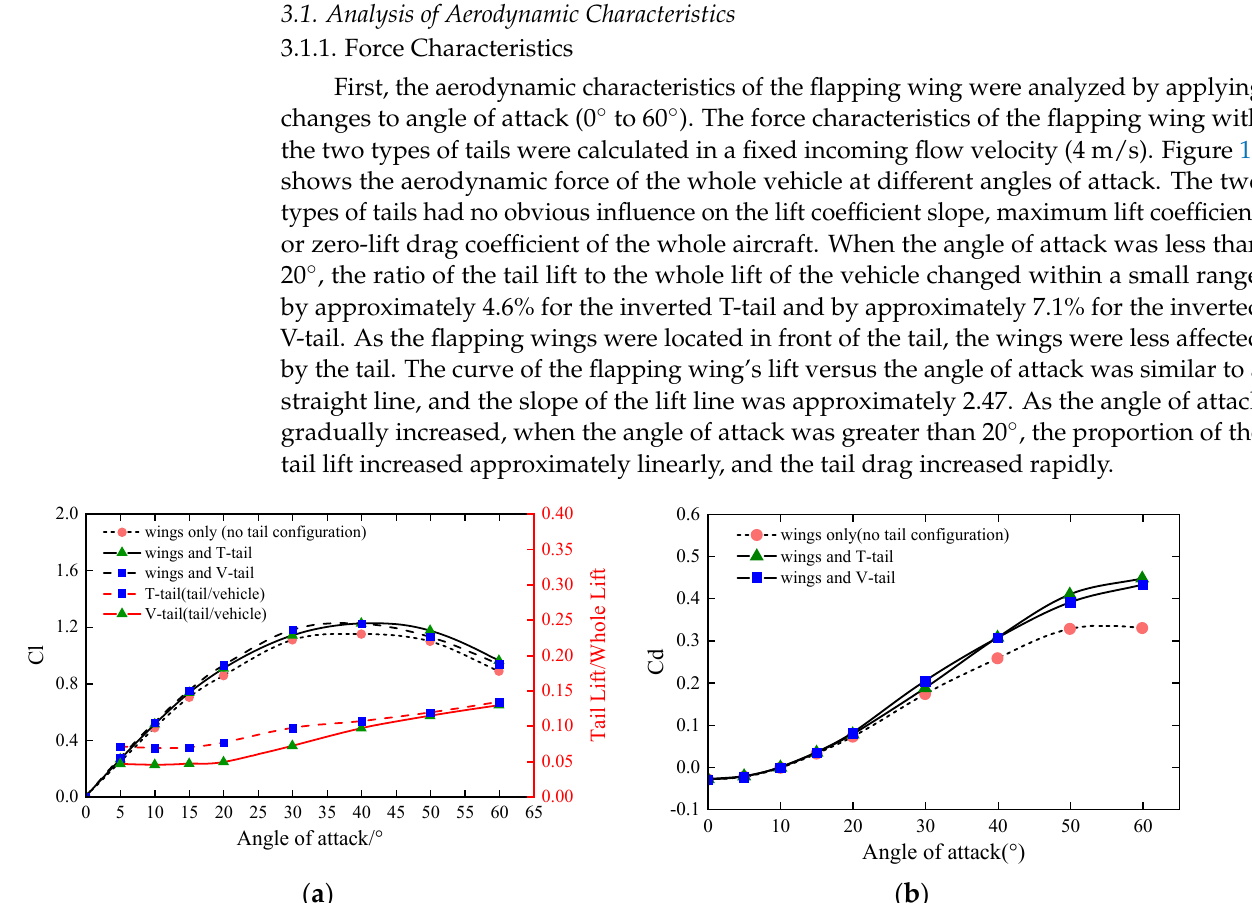
( b ) ( c ) Figure 12. Tails’ force characteristics. ( a ) Lift coefficient curve. ( b ) Drag coefficient curve. ( c ) L/D ratio. 3.1.2. Moment Characteristics In the forward flight state at 4 m/s velocity, the control moment of the tails decreased continuously with the increase in the angle of attack. Figure 13 shows the curve of the control moment changing with the angle of attack when the inverted T ‐ tail and V ‐ tail deflected 45°. The three moments were approximately linear and decreased rapidly, that is, the control effects caused by the tail control surfaces at a large angle of attack were weak. When the angle of attack was less than 30° , the pitch moment of the inverted T ‐ tail decreased relatively slowly due to the effect of the wake reducing the incoming angle. When the angle of attack was greater than 30° , the pitch moments of the two tails were almost the same. Due to the lateral ‐ directional coupling of the inverted V ‐ tail, the yaw moment was slightly smaller than the inverted T ‐ tail, but, at the same time, it produced a roll that was beneficial to the aircraft’s lateral ‐ directional maneuvering and improved flight performance. In a cruising state (4 m/s, 10°), the pitch control moment of inverted V ‐ tail is 12.8% greater than that of the inverted T ‐ tail. Although the directional control 0